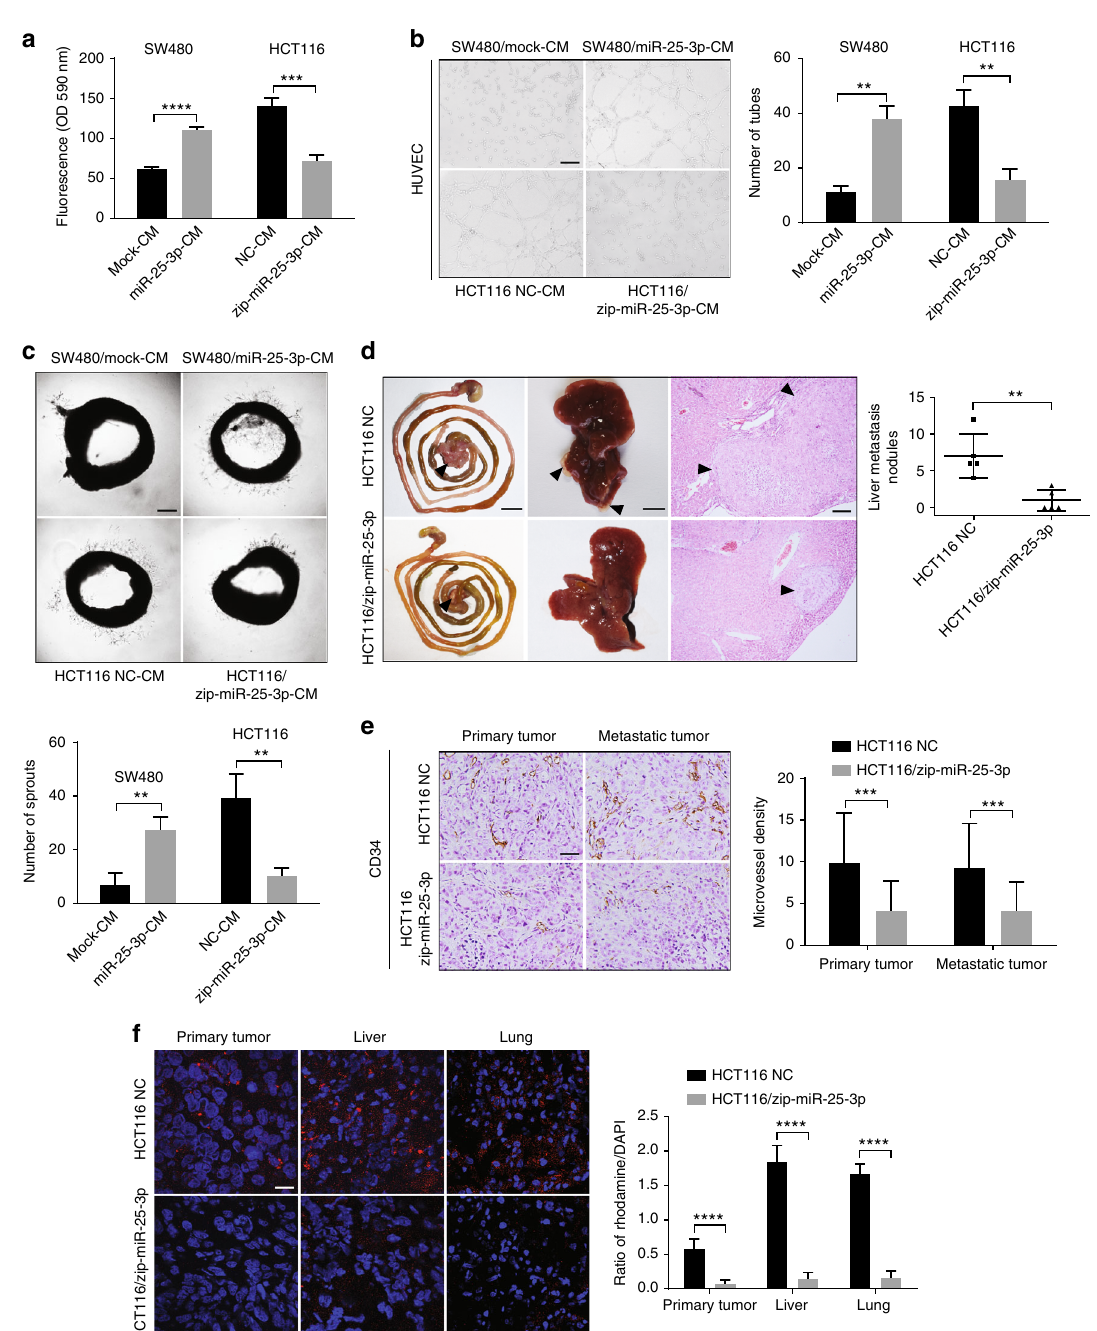
Fig. 6 MiR-25-3p promotes CRC metastasis. a Effects of condition media derived from SW480/mock, SW480/miR-25-3p and HCT116 NC, HCT116/miR- 25-3pon permeability of HUVEC monolayers by in vitro permeability assay. Mean ± SEM are provided ( n = 3). b Top, effects of condition media derived from SW480/mock and SW480/miR-25-3p on tube formation ability of HUVECs by tube formation assay. Bottom, effects of condition media derived from HCT116 NC and HCT116/miR-25-3p on tube formation ability of HUVECs. Scale bar represents 100 µ m. Mean ± SEM are provided ( n = 3). c Top, effects of condition media derived from SW480/mock and SW480/miR-25-3p on vascular outgrowth of rat aortic rings. Bottom, effects of condition media derived from HCT116 NC and HCT116/miR-25-3p on vascular outgrowth of rat aortic rings. Scale bar represents 200 µ m. Mean ± SEM are provided ( n = 3). d Effect of miR-25-3p knockdown on liver metastasis of mice. HCT116 NC or HCT116/miR-25-3p was injected into the mesentery at the tail end of cecum. The number of lung metastatic sites (indicated by arrows) was counted under the microscope. Mean ± SEM are provided ( n = 5). Scale bar in left panels represents 1 cm. Scale bar in middle panels represents 0.5 cm. Scale bar in right panels represents 100 µ m. e Effect of miR-25-3p knockdown on introtumoral microvessel density in primary and metastatic tumor. The number of microvessel was counted under the microscope. Mean ± SEM are provided ( n = 5). Scale bar represents 50 µ m. f Effect of miR-25-3p knockdown on hepatic and pulmonary vascular permeability in primary and metastatic tumor. The liver and lung were derived from mice 30 days after being orthotopically implanted with HCT116/zip-miR-25-3p cells. Levels of rhodamine – dextran fl uorescence in tissues were quanti fi ed using Image J software and normalized to the levels of DAPI. Mean ± SEM are provided ( n = 5). Scale bar represents 50 µ m. ** P < 0.01, *** P < 0.001, **** P < 0.0001 according to two-tailed Student ’ s t